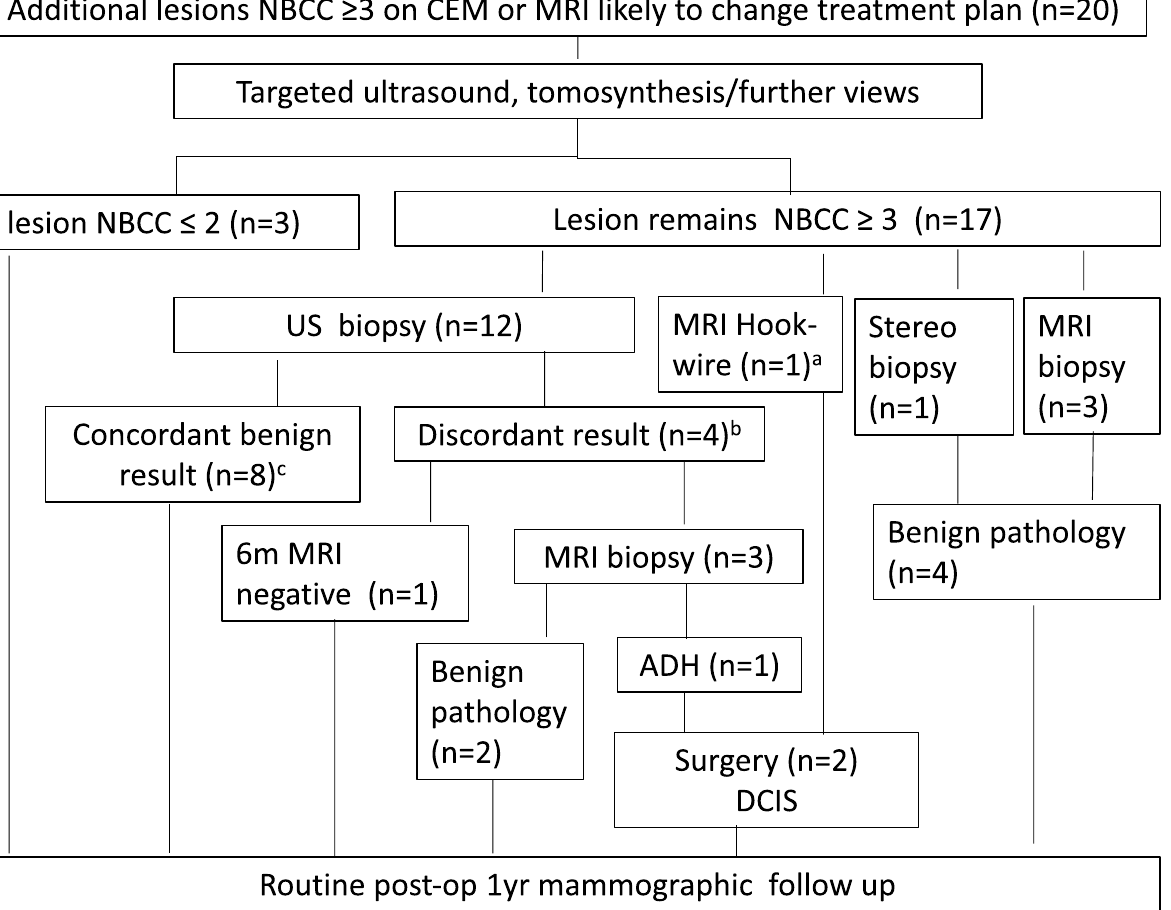
Fig. 2 Results of assessment procedures. a Additional lesion excised “en-bloc” with index lesion following preoperative MRI-guided hook-wire insertion. b Discordant histopathology or biopsy marker clip position. c One lesion was ADH at surgery. ADH Atypical ductal hyperplasia,